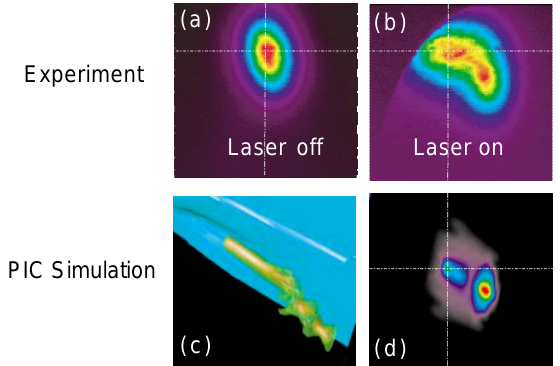
FIG. 2. (Color) Images of the electron beam showing refraction of a portion of the beam. (a) Cerenkov image without the plasma (i.e., laser off). (b) Cerenkov image with the laser on at an angle f of 1 mrad to the beam. The crosshairs show the undeflected beam location. This shows a characteristic splitting of the beam into two in qualitative agreement with the simulation shown below it. (c) PIC simulation of electron beam, side view with plasma shown (blue). The inward motion of the plasma electrons is visible as a depression in the blue plasma surface behind the beam. (d) PIC simulation, head on view corresponding to (b). The code used was OSIRIS , is described in Ref. [10]. The simulation parameters were chosen to be similar to the experiment; namely, a 30 GeV beam with 2 3 10 10 electrons in a bi-Gaussian distribution (spot size s r (cid:1) 70 m m, bunch length s z (cid:1) 0.63 mm) incident on a plasma of density 2 3 10 14 cm 2 3 . In the simulation, the beam propagated through approximately 80 cm of plasma before encountering a sharp plasma/vacuum boundary at an incident angle of 0.9 mrad in the x - z plane. The model consisted of 2 3 10 7 particles on a 160 3 120 3 88 grid representing a 2.9 mm 3 2.2 mm 3 6.5 mm section of plasma (cid:2) x , y , z (cid:3) moving with the beam ( z